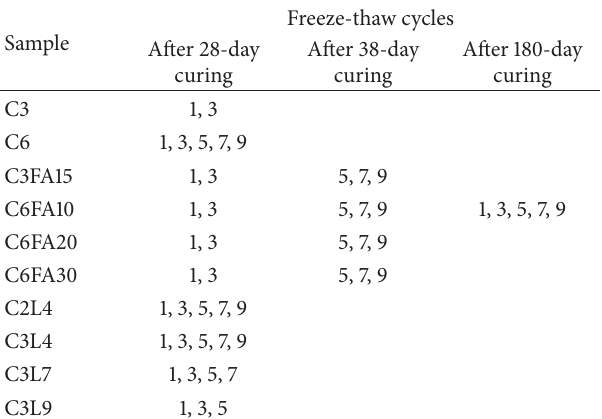
Table 4: Freezing-thawing